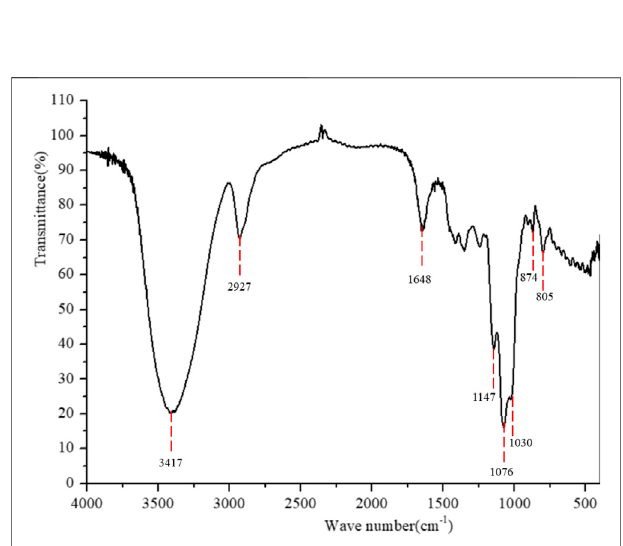
FIGURE 3 | Surface morphological characterization of PPp-W from P. placentodes . Scanning electron microscopy image (A) . X-Ray diffraction spectrum image (B) . Congo red test – triple-helix structure analysis (C) . Atomic Force Microscopy image (D) .